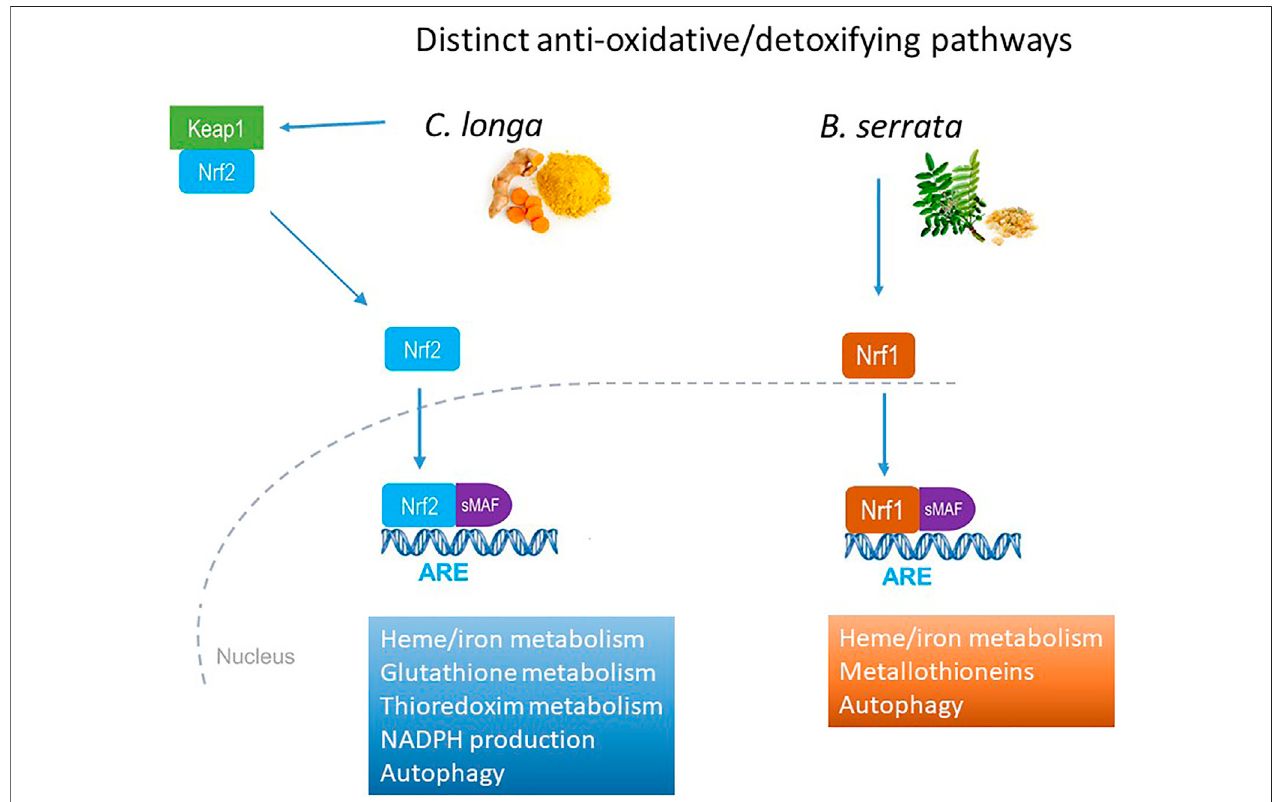
FIGURE 4 | Distinct anti-oxidative and detoxifying pathways activation by C. longa and B. serrata on OA chondrocytes.